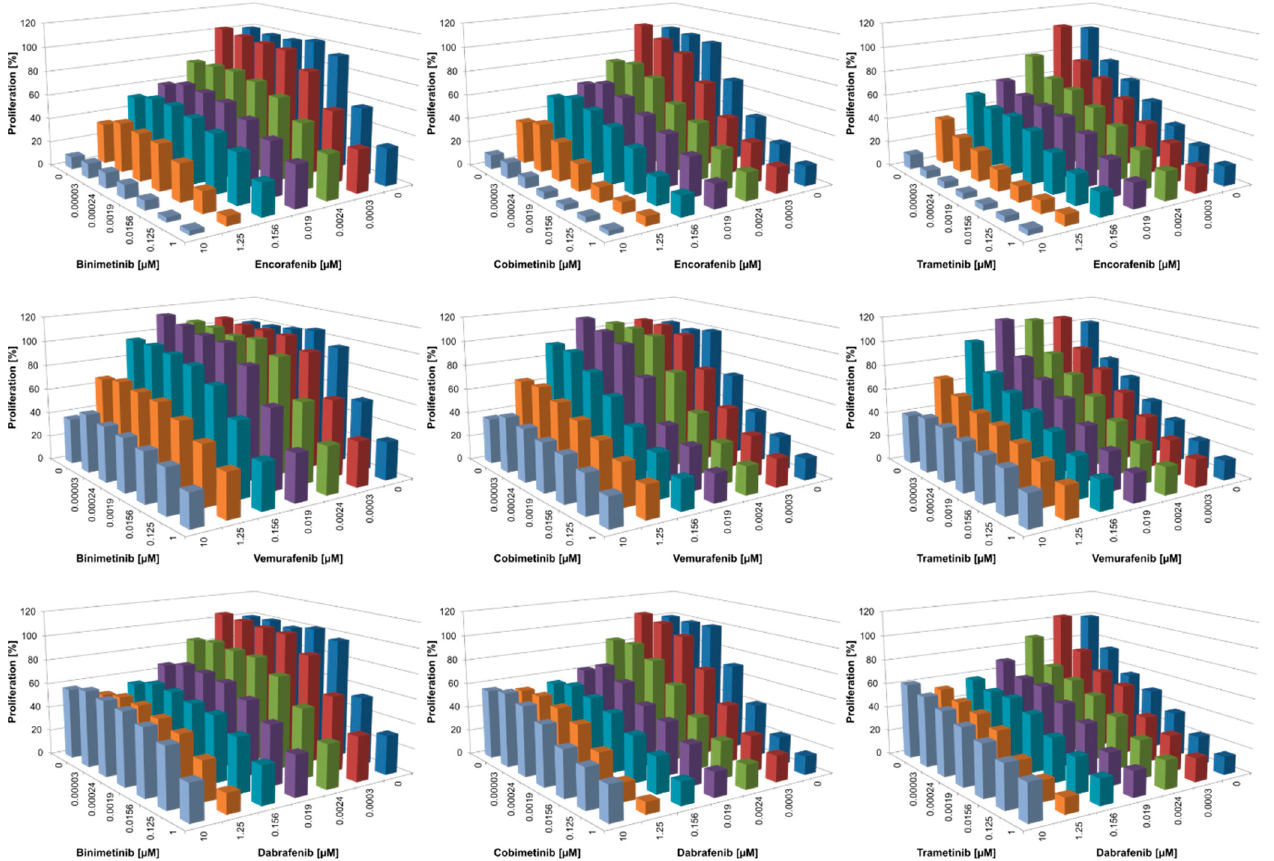
Figure 3. Inhibition of proliferation of Malme3M (BRAF mut ) after treatment for 72 h with single or combined BRAFi/MEKi (serial dilutions 1:8); n ≥ 3; for simplicity, standard deviation and significance are not shown. Significance from these data is displayed in Figures S2 and S3. List of p -values can be found in Tables S5 and S6.